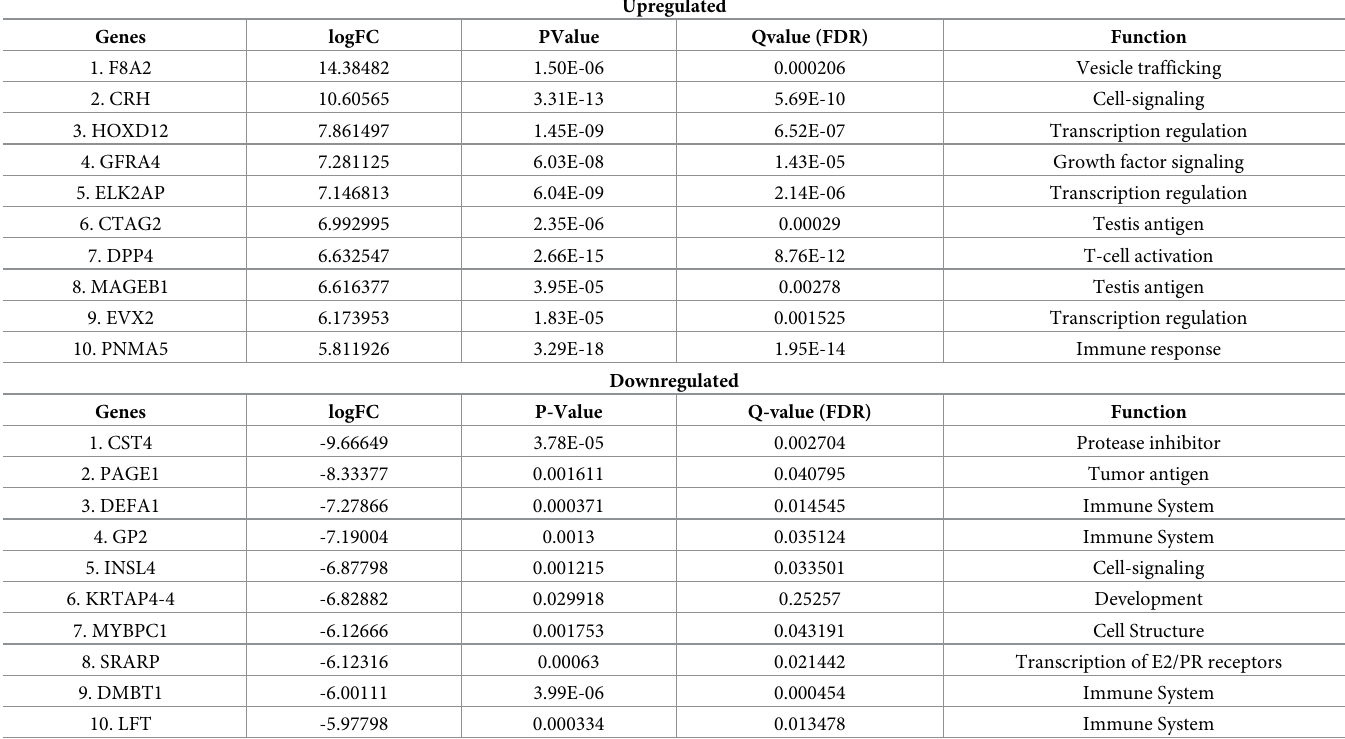
Table 6. Top significant differentially expressed genes comparing DACH1 mutated patients to wild-type and their associated pathways. (A) Upregulated pathways in DACH1 mutated patients compared to wild-type. (B) Downregulated pathways in DACH1 mutated patients compared with wild-type.